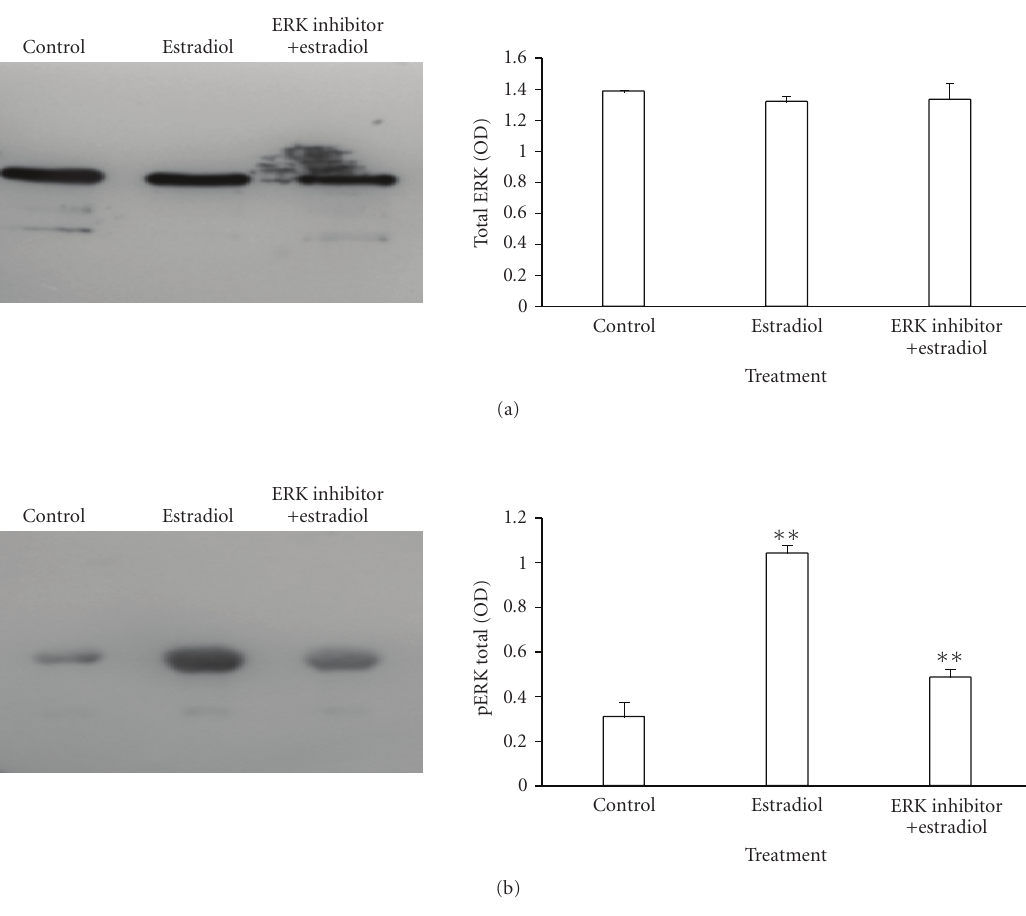
Figure 3: ERK-like protein detection in Taenia crassiceps . Total ERK-like protein in T. crassiceps was not modified by 17 β -estradiol or ERK inhibitor treatments (a), contrary to that observed in ERK-like gene expression. Nevertheless, 17 β -estradiol specifically induced phosphorylation of ERK-like by four-fold respect to control groups (b). Optical densitometry was performed on 10% acrylamide gel from six independent experiments. Control = Parasites treated with the vehicle where hormone and inhibitors were dissolved; ∗∗ P < .